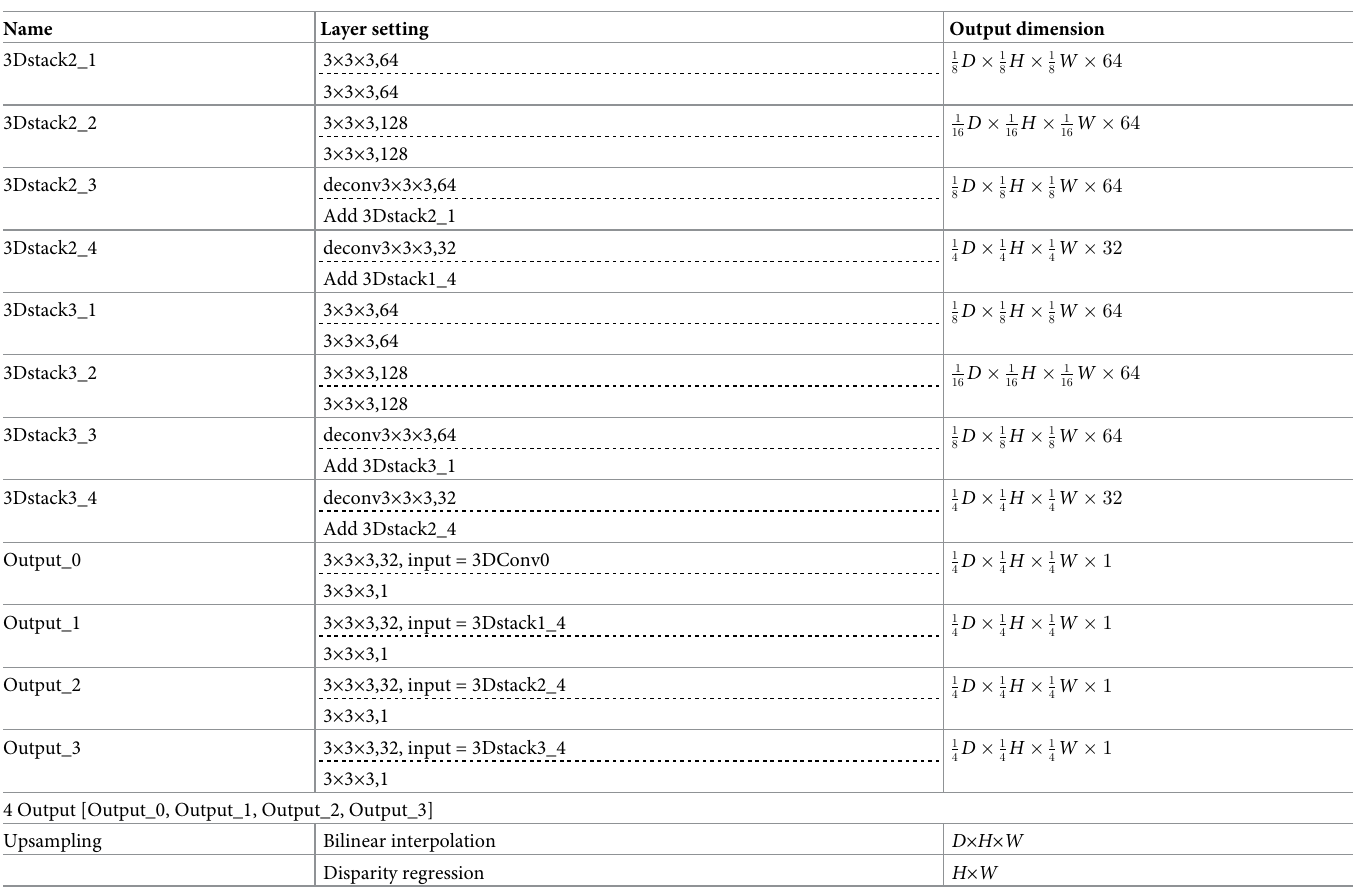
number of parameters while obtaining the same perceptual domain. As shown in Table 1, the output image size is 1 H � 1 W . In addition, conv2_x, conv3_x, and conv4_x are the bottleneck 4 4 models of the residual networks. For ASPP, four parallel branches are formed by the atrous convolution with different expansion rates. The concept of the dilation rate is introduced in the atrous convolution. Here, Fig 2A represents the atrous convolution with a 3 × 3 convolution kernel and a dilation rate of one, that is, the ordinary convolution; Fig 2B shows the atrous convolution with a 3 × 3 convolution kernel and an expansion rate of 2. Since only 9 points and 3 × 3 convolution kernels are involved, other issues are not addressed. Therefore, even if the convolution kernel’s size is only as shown in Fig 2C, the receptive field of the cavity with a 3 × 3 convolution kernel and an expansion rate of 4 has increased to 15 × 15. The atrous convolution, which increases the receptive field without changing the image resolution, can completely replace the pooling operation. The output of each convolution contains a broad range of image feature information. The feature map extracts the spatial information of different scales through four branches. The four units can complement each other, and the output is accumu- lated to obtain the feature map with different scales and a broad range of receptive fields. The model structure is shown in Fig 3. Because the importance of the information contained in each feature graph is different, inspired by SENet [23], we give each feature graph a specific weight, and the